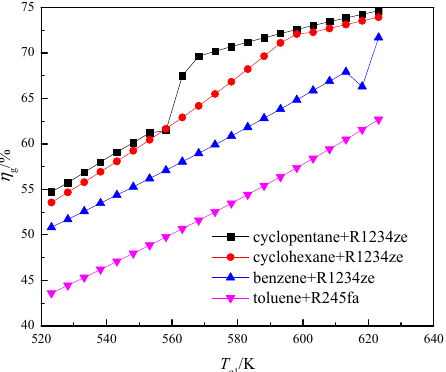
Figure 12. Effects of T g1 on the heat utilization ratio of the engine exhaust gas.